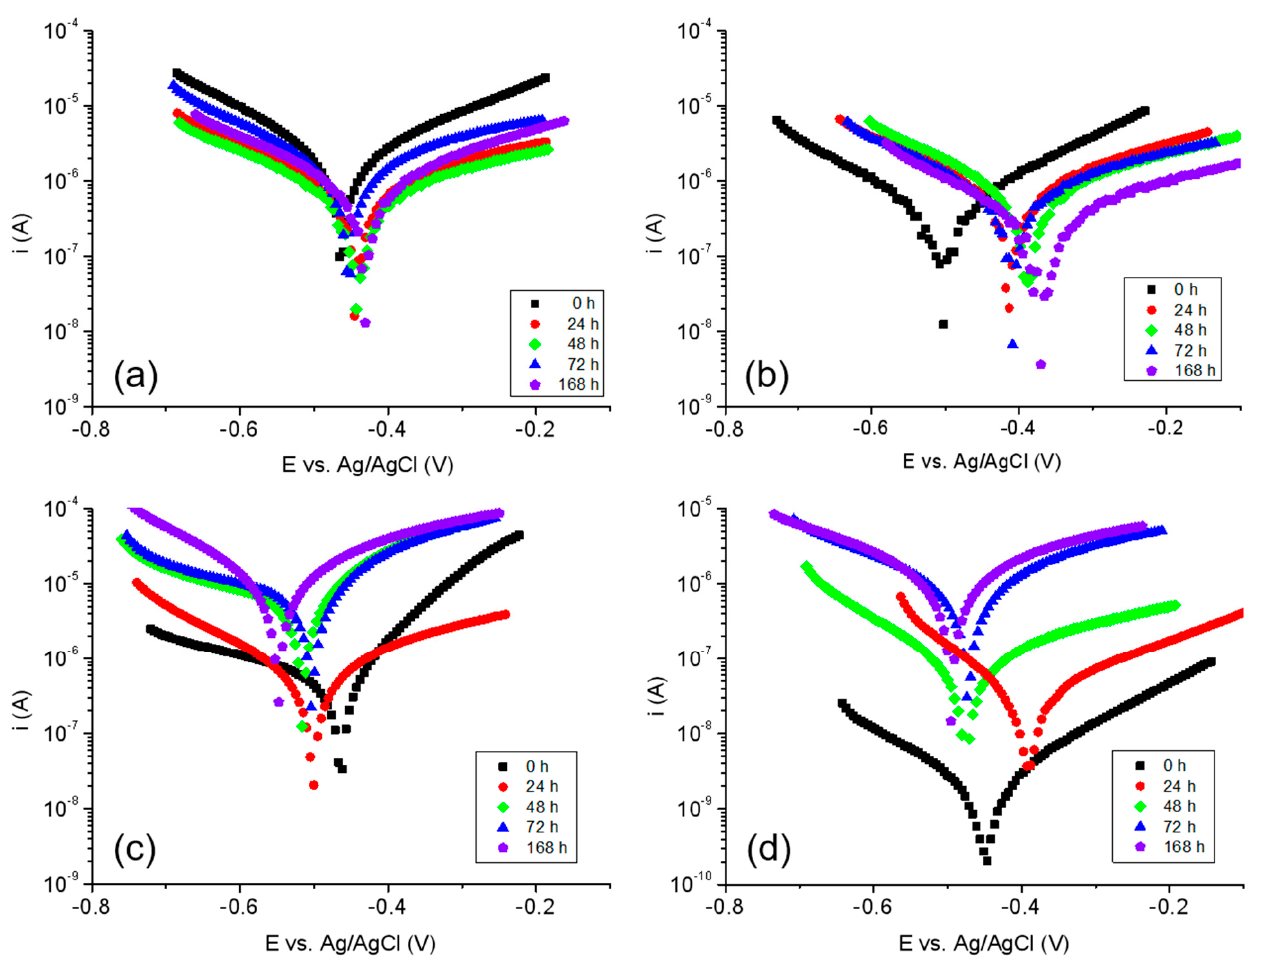
Figure 6. Tafel plots over time for ( a ) etched TiZr in 0.9% NaCl; ( b ) etched TiZr in SBF; ( c ) etched TiZr covered with PLA nanofibers in 0.9% NaCl; ( d ) etched TiZr covered with PLA nanofibers in SBF. Table 5. Electrochemical parameters of potentiodynamic polarization curves of the different sam- ples.